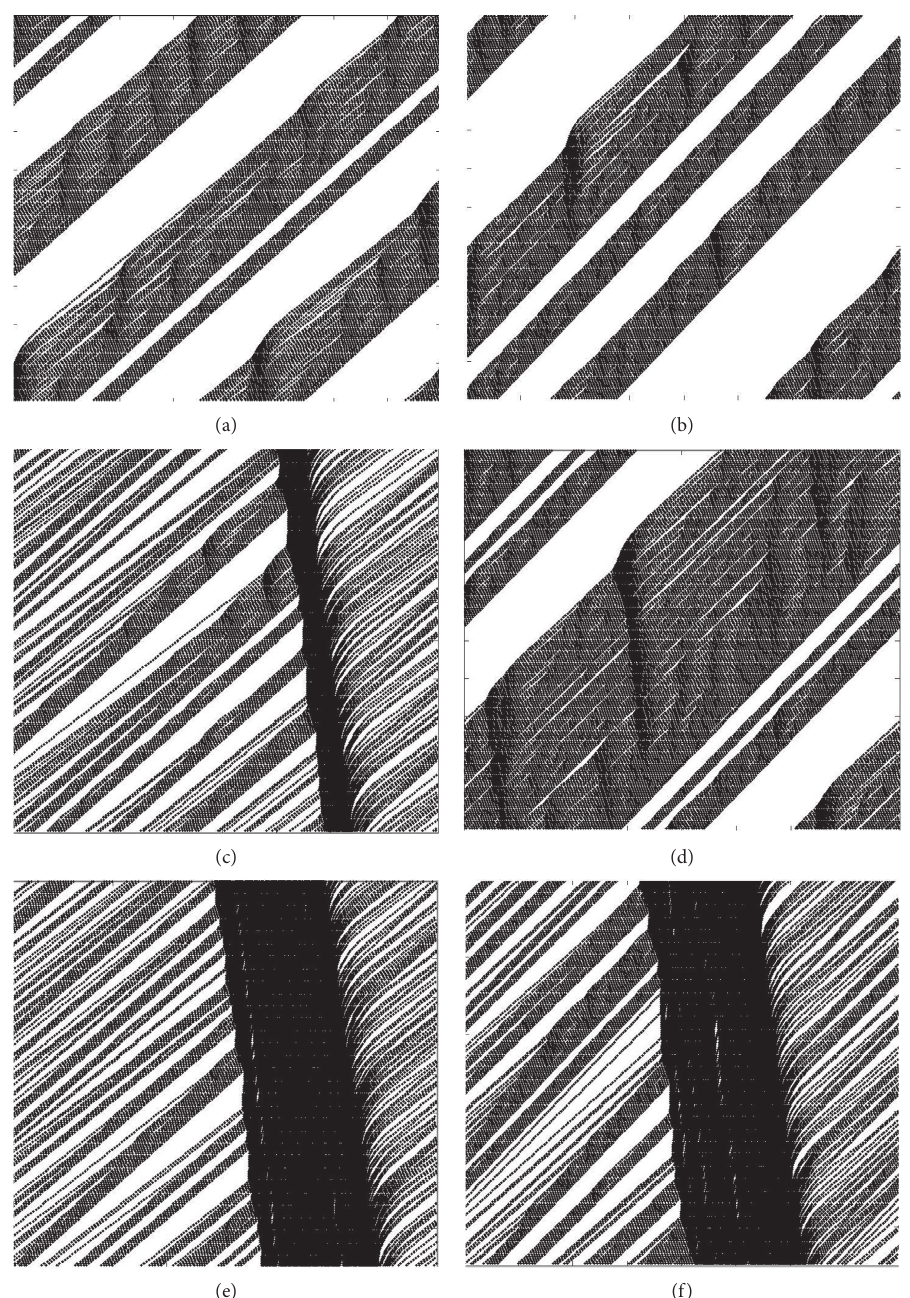
Figure 4: Time-space diagrams for controlled and uncontrolled situations. (a, c, e) Time-space diagrams at k � 0.1, 0.15, and 0.3 density in uncontrolled state. (b, d, e) Time-space diagrams of VSL � 100km/h at k � 0.1, 0.3, and 0.5